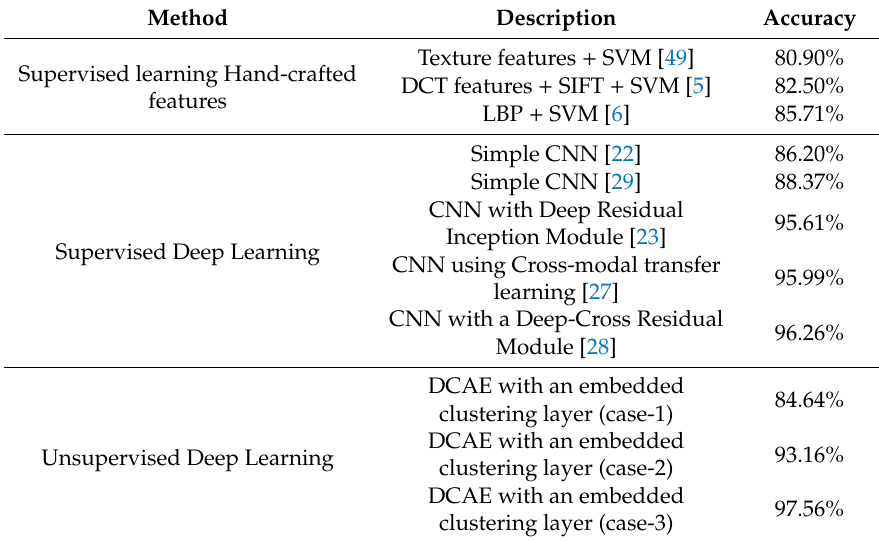
Table 2. Comparative study for the SNPHEp-2